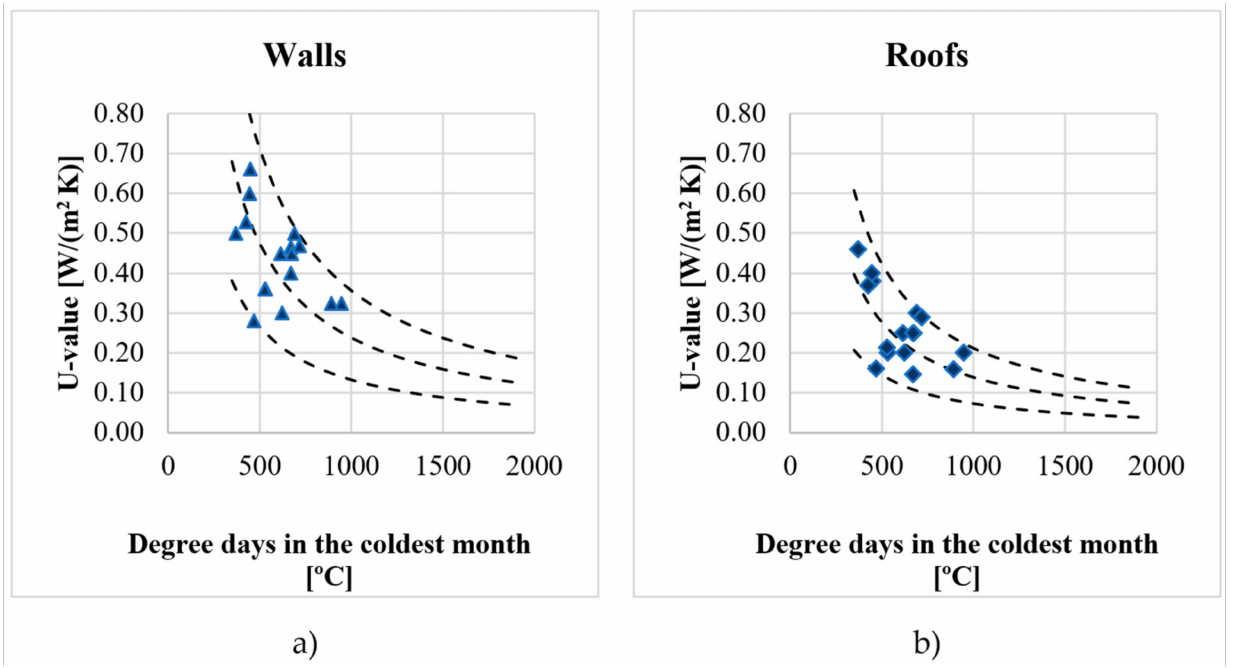
Figure 2. Law for the assignment of U-values with heating degree days in the coldest month in each city: ( a ) walls, ( b ) roof.